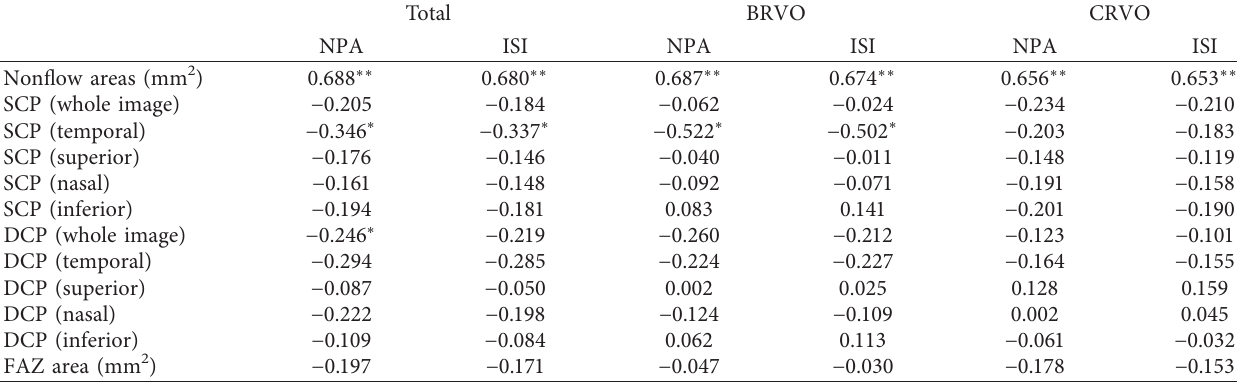
Table 4: Correlation between the NP area and ISI on UWFFA and OCTA parameters of